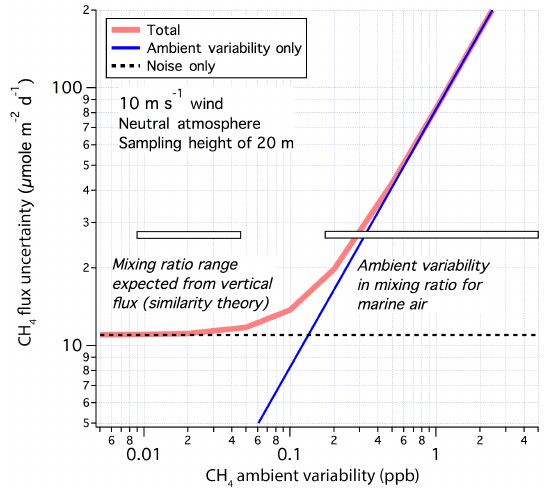
Figure 9. Estimated uncertainty in hourly averaged EC flux of CH 4 . Typical observed and predicted (based on similarity theory for the open ocean) values of the ambient variability in CH 4 mixing ratio are shown by the horizontal